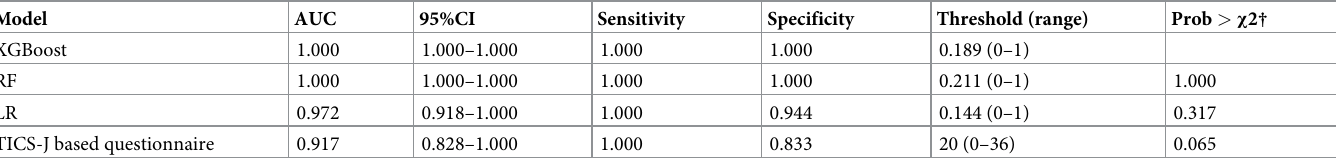
Table 4. Predictive performance of the models built for each participant for predicting